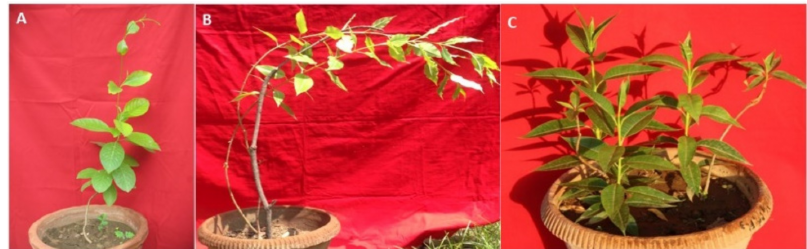
Figure 3. Mother plant. ( A ) D. hamiltonii . ( B ) D. arayalpathra . ( C ) D. salicifolia